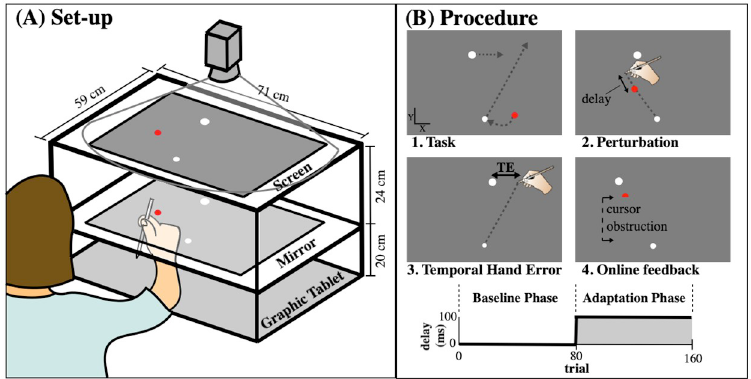
Fig 1. Set-up and procedure. A. Set-up of the task: The task image was projected onto a screen that was visible for the subject through a mirror. Recorded movements with a stylus were made on a graphic tablet. The hand and hand- held stylus were blocked from view by the mirror. B. Task procedure: (1) A white dot at the bottom of the screen (diameter = 6 mm) indicated the start location. A red cursor represented the movements made by the stylus (diameter = 6 mm). The trial initiated when the participant moved the cursor to the start location. The goal of the task was to intercept a ball (diameter = 10 mm) moving from left to right or vice versa with a straight ballistic movement. (2) During the adaptation phase there was a temporal perturbation (delay) of 100 ms between the hand and cursor. (3) The Temporal Hand Error (TE) was defined as the temporal lead or lag of the stylus (hand) crossing the target’s trajectory line in relation to the target. A lead was denoted by a positive TE, and a lag with a negative TE. (4) In the area within the dashed lines, vision of the cursor was obstructed from view.